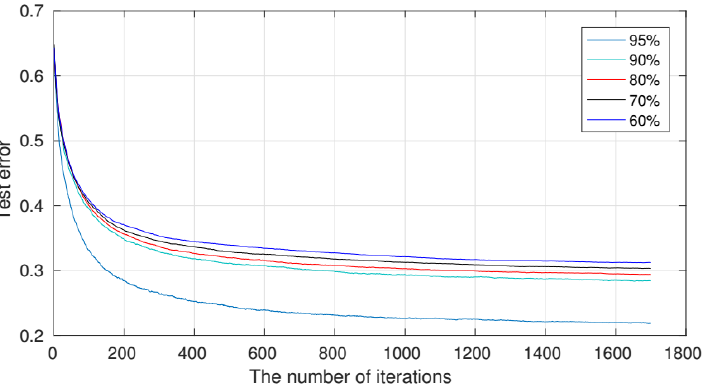
Figure 3. The relationship between the test error and error bars, training time, as well as training data